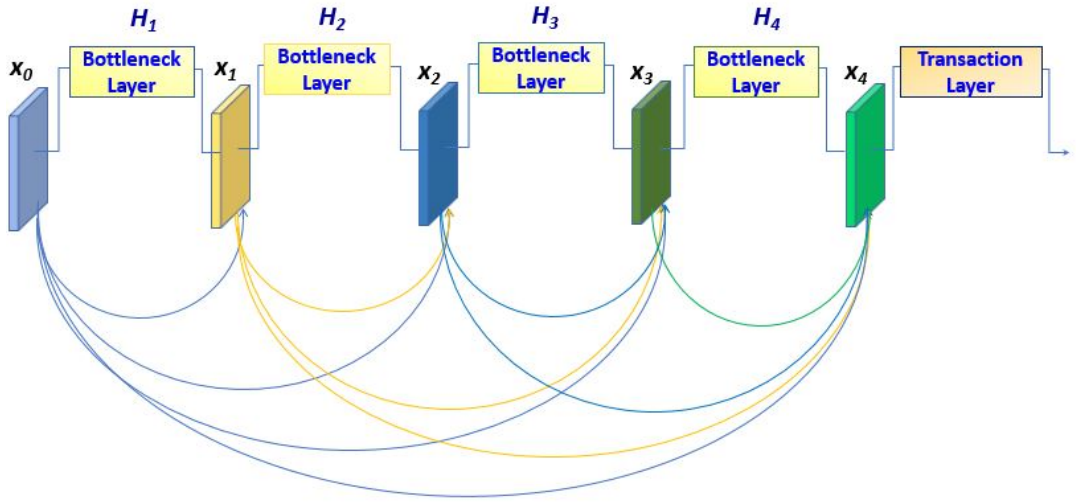
Figure 2. Direct connections in DenseNet201.